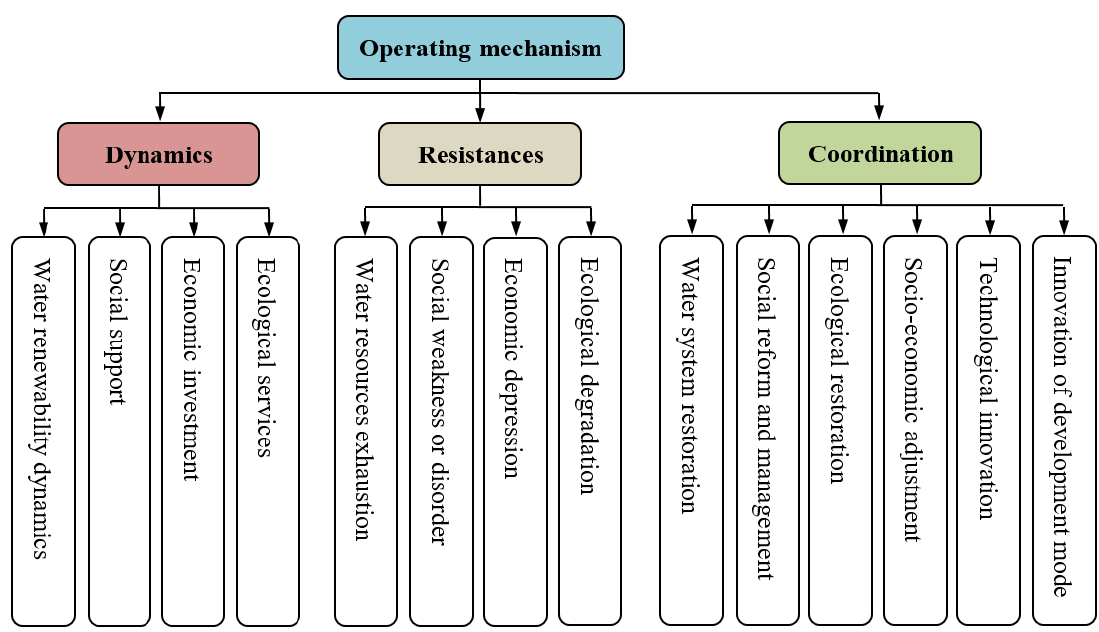
Figure 3. Operating mechanisms of an SWRS and its components.